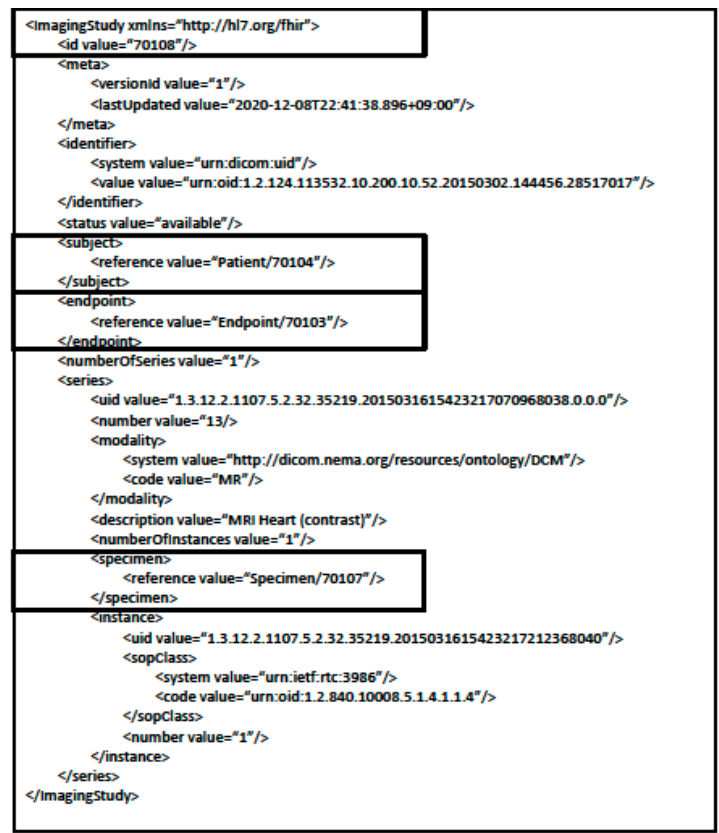
Figure 6. Example of ImagingStudy Resource XML Transmission Results.